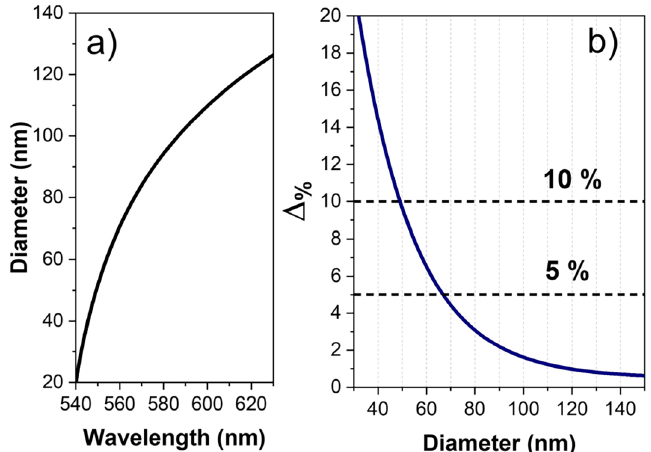
Figure 6. ( a ) Theoretical dependence of Eq. (1) that establishes the dependence between the nanoparticle diameter and the wavelength of the plasmon resonance peak. ( b ) Theoretical percentage uncertainty in the estimation of the nanoparticle diameter with